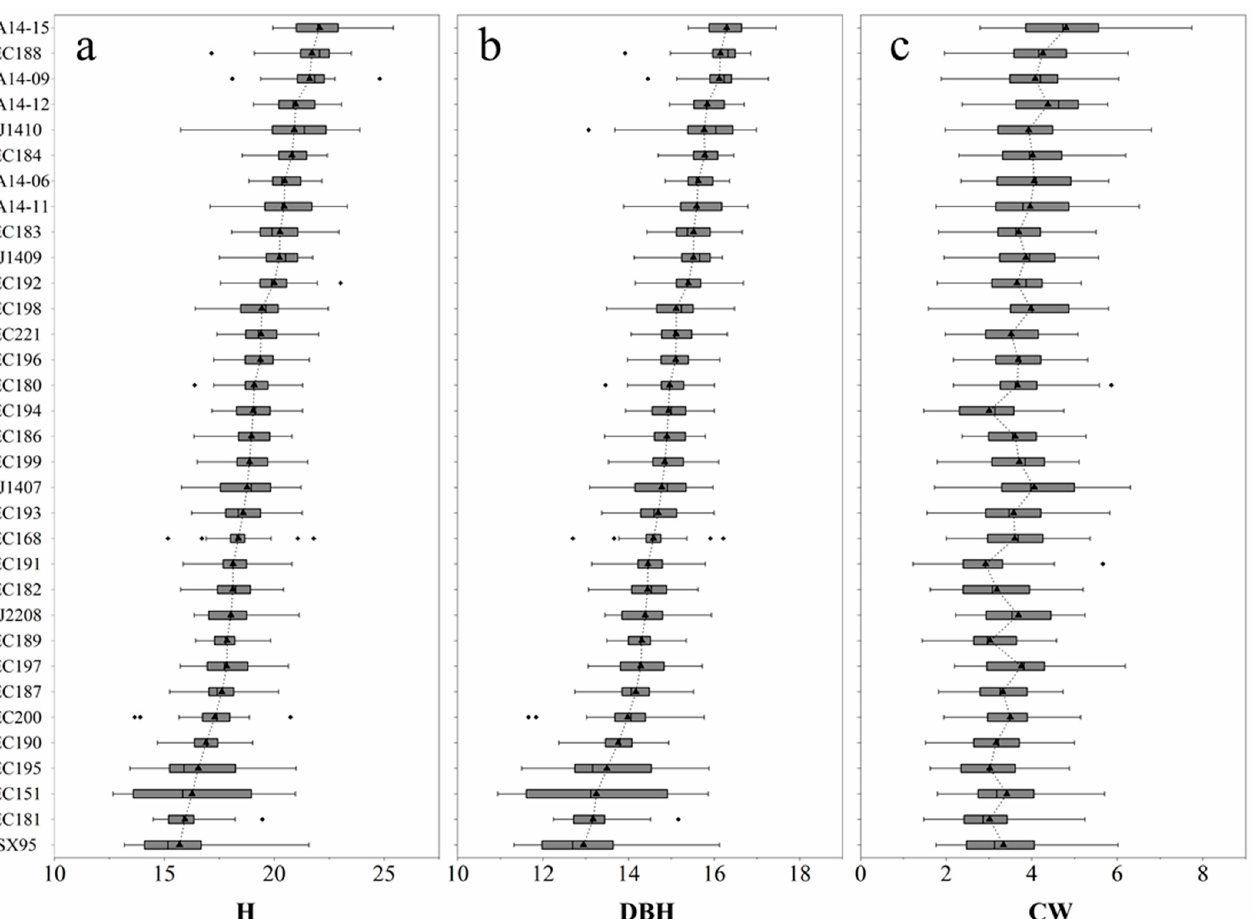
Figure 6. Differences of tree growth traits among 33 eucalypt clones. ( a ) Tree height (H); ( b ) diameter at breast height (DBH); ( c ) crown width (CW). The clones are arranged in the order of H and DBH from high to low, and the boxes are connected with dotted lines to indicate the high and low trends. The black diamond point represents the abnormal value with a coefficient of 2, the black triangle in the box represents the average value, and the solid line is the location of the median value.